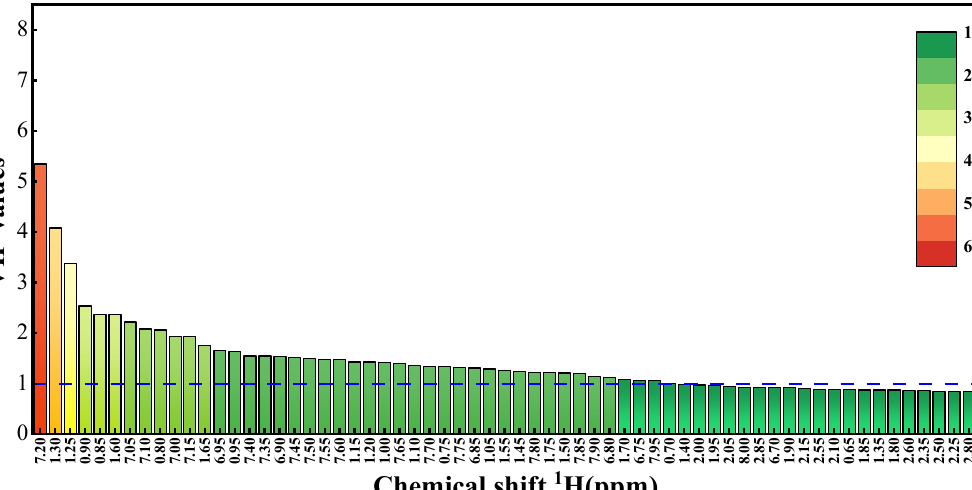
Figure 10. VIP values of asphalt samples.